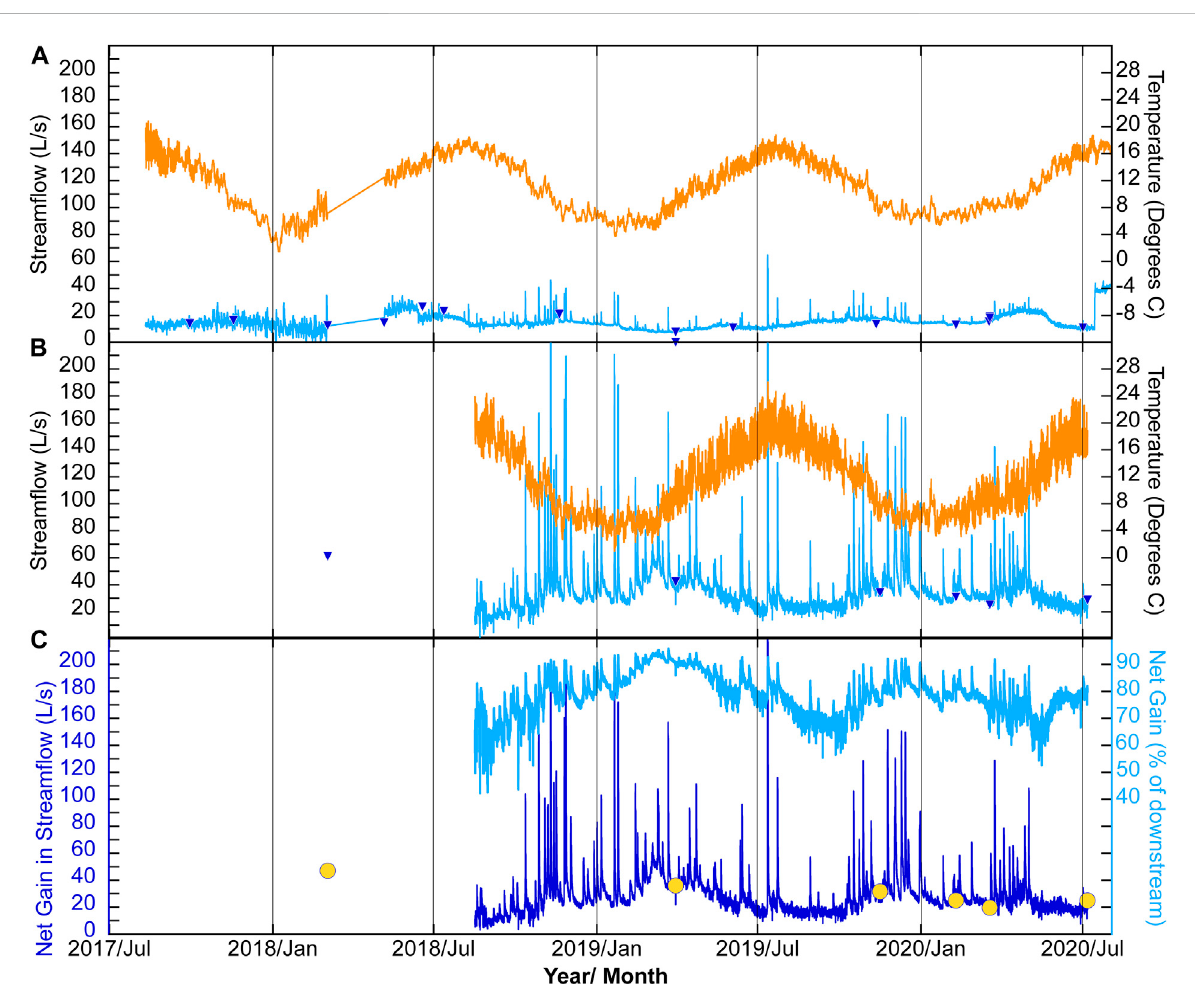
FIGURE 3 Stream fl ow gains at Foothills Preserve. (A) Manual measurements (symbols) and time series of discharge ( Q [L/s], blue) and temperature ( ° C, orange) upstream, (B) downstream, and (C) net gain along the 550-m reach ( Δ Q [L/s], dark blue) or as a % of downstream fl ow (light